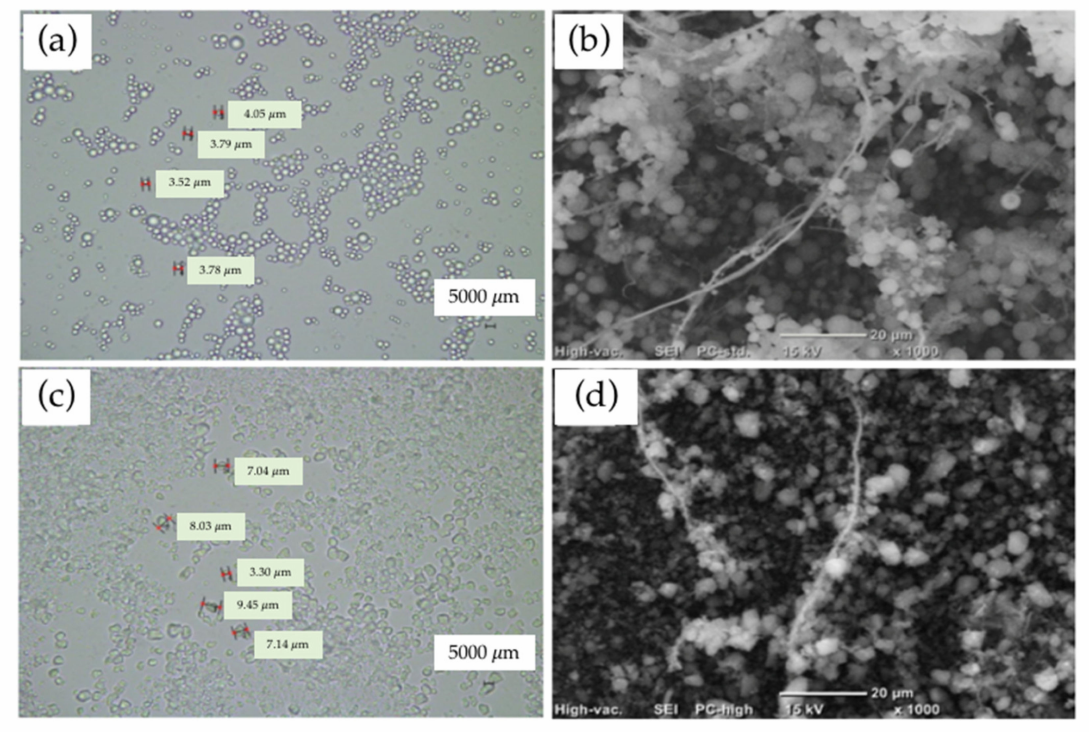
Figure 3. Morphological image of SiP particles: ( a ) SiP SS 50X, ( b ) SS/CNF 1000X, ( c ) SiP SP 50X, and SEM image of hybrid filler, ( d ) SP/CNF